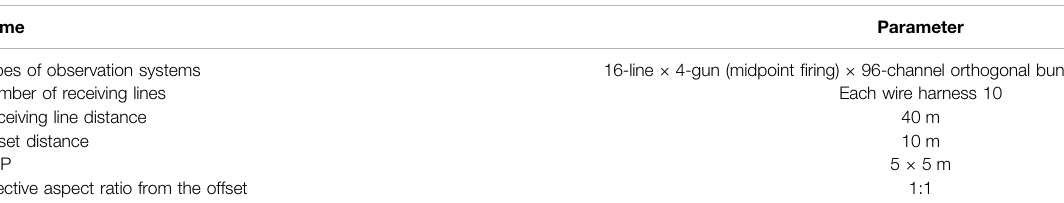
TABLE 2 | Main parameters of the observation system.